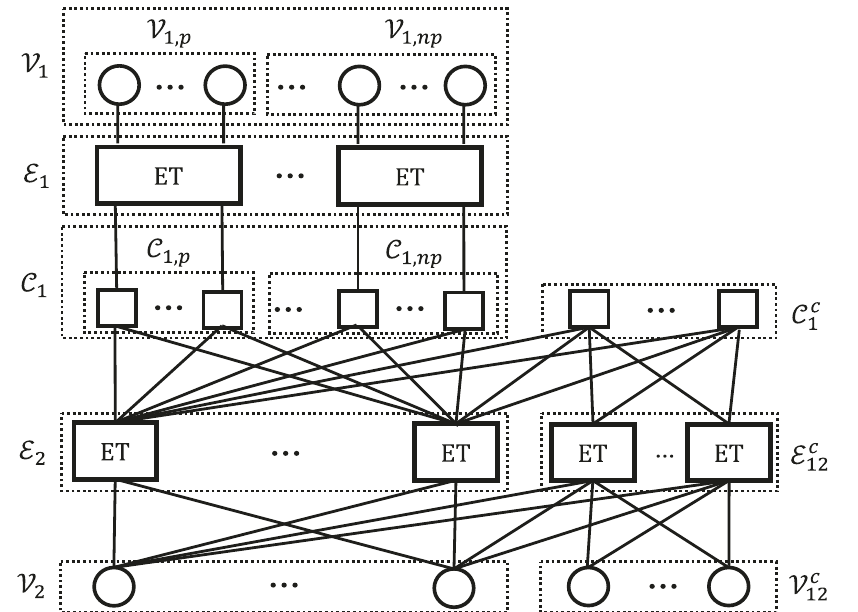
Fig. 1 Tanner graph of MET-LDPC code ensemble with degree-one variable nodes. The block denoted by ET are uniform interleaver each of which permutes edges of a